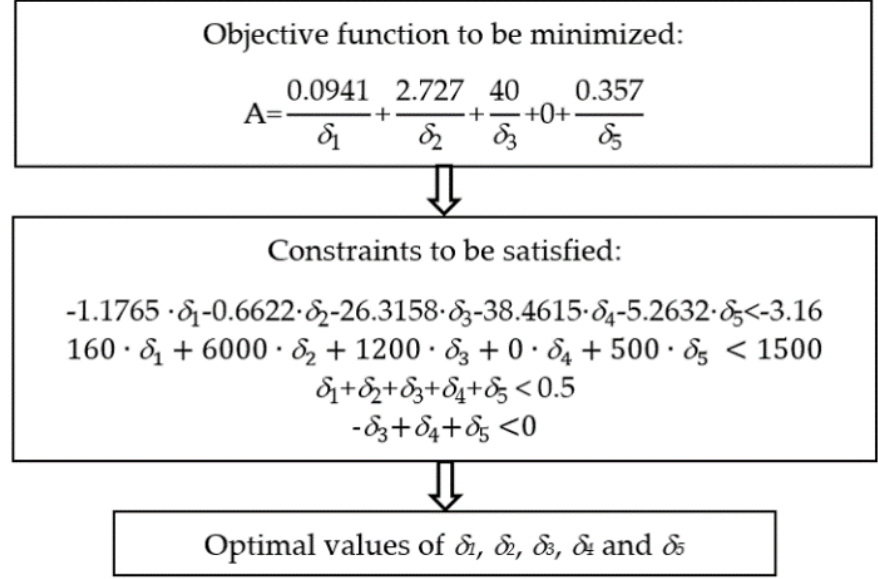
Figure 2. The genetic algorithm operating scheme. The second constraint was a function of the unit price of a material used for the con- struction of the wall layers per running meter (RSD/m; RSD is Serbian Dinar currency—1 Euro ≈ 117.5 RSD). The function was defined to depend on the unit price of the material per square meter and on thickness of the wall layers and it was expressed in the following